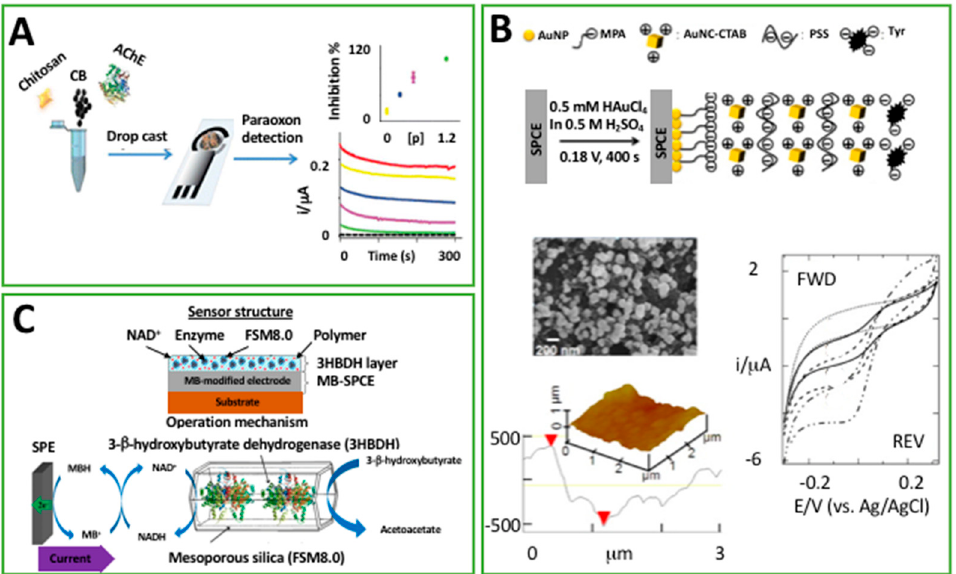
Figure 4. ( A ) Biosensors based on screen-printed electrodes modified with Acetylcholinesterase, carbon black, and chitosan for organophosphorus pesticide detection (permission of [61]); ( B ) schematic diagram showing the layer by layer process on an gold nanoparticles (AuNP)-deposited SPE, including SEM and AFM (Atomic Force Microscopy) images alongside the height profile of the platform. Representative cyclic voltammograms for different concentrations of catechol using the Tyrosinase-modified platform (permission of [40]); ( C ) layer structure and operation mechanism of 3HB biosensor (Permission of [65]).